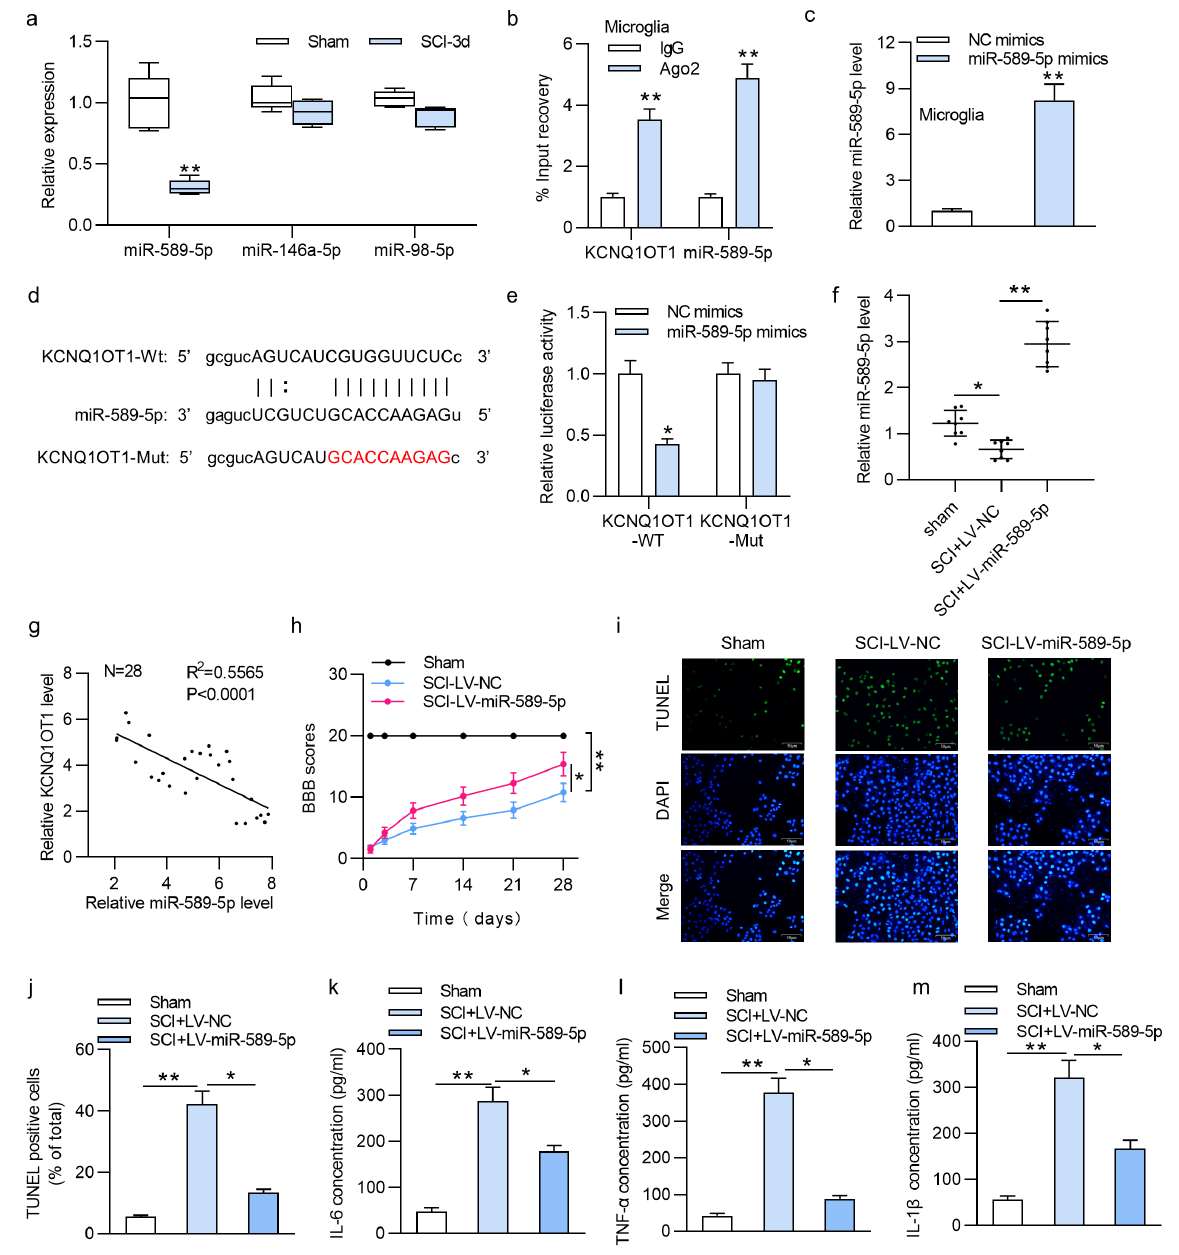
Figure 3. KCNQ1OT1 bound with miR-589-5p. (a) The expression of miR-589-5p, miR-146a-5p and miR-98-5p in SCI mice was detected by RT-qPCR. (b) RIP revealed KCNQ1OT1 and miR-589-5p were in the same RNA-induced silencing complex (RISC). (c) RT-qPCR displayed the expression of miR-589-5p in microglia from the SCI mice after transfection of miR-589-5p mimics. (d) The putative binding site between KCNQ1OT1 and miR-589-5p was exhibited. (e) Luciferase reporter assay showed KCNQ1OT1 bound with miR-589-5p. (f) RT-qPCR delineated miR- 589-5p expression after LV-miR-589-5p injection into SCI mice. (g) Pearson’s correlation analysis unveiled the correlation between expression of miR-589-5p and KCNQ1OT1 expression in SCI mice. (h) BBB scores was used to analyze the neurological function of the mice. (i-j) The number of TUNEL positive cells in different groups was measured by TUNEL staining. (k-m) ELISA was used to measure the concentrations of IL-6, TNF-α and IL-1β in different groups. N=8 in each group for h-m. * p < 0.05. ** p <